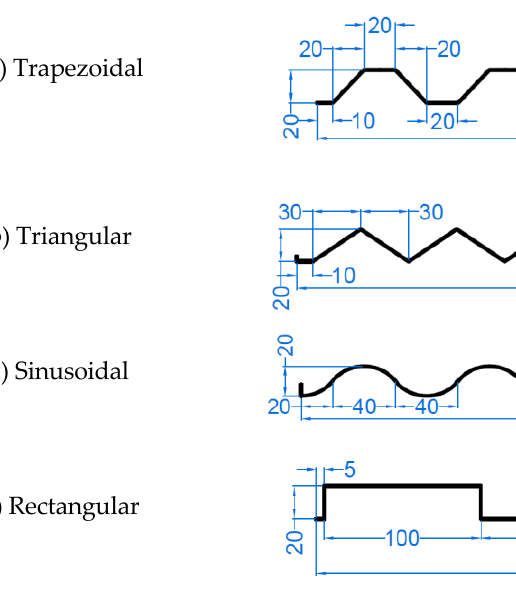
Table 1. Side and 3D views of the six corrugated layers composing the aluminium cores of different topologies, posi- tioned in a steel frame. ( a ) Trapezoidal; ( b ) Triangular; ( c ) Sinusoidal; ( d ) Rectangular. Topology Side View of the Core